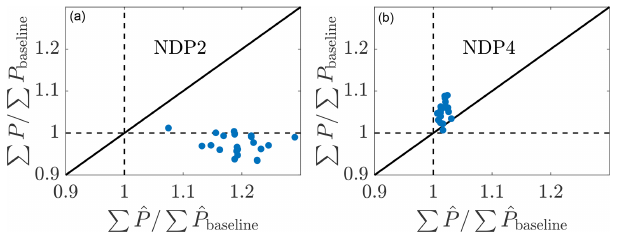
Figure 20. Relationship between the LES wind farm power pro- duction compared to the wake model wind farm power production prediction for online control using the initial parameters to initialize the next state and (a) ˆ P p = 2 (NDP2) and (b) ˆ P p = 4 (NDP4). The LES power production is given by P , and the wake model predic- tion is given by ˆ P .